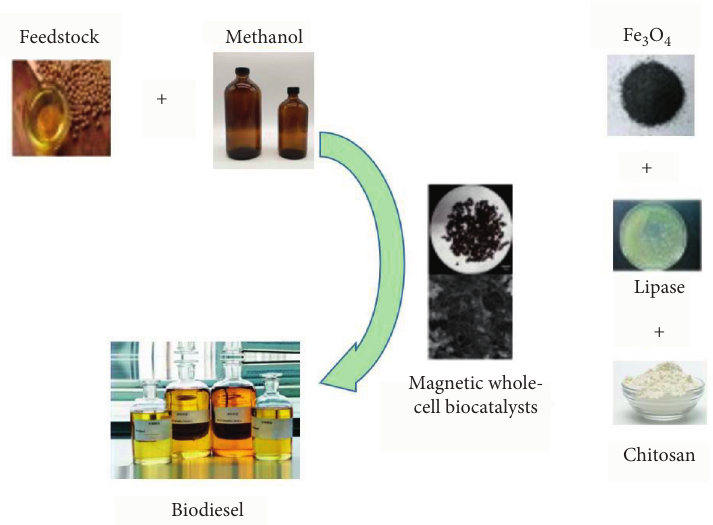
Figure 10: The magnetic chitosan biocatalysts. Reproduced with permission from [56] copyright 2016, Elsevier.